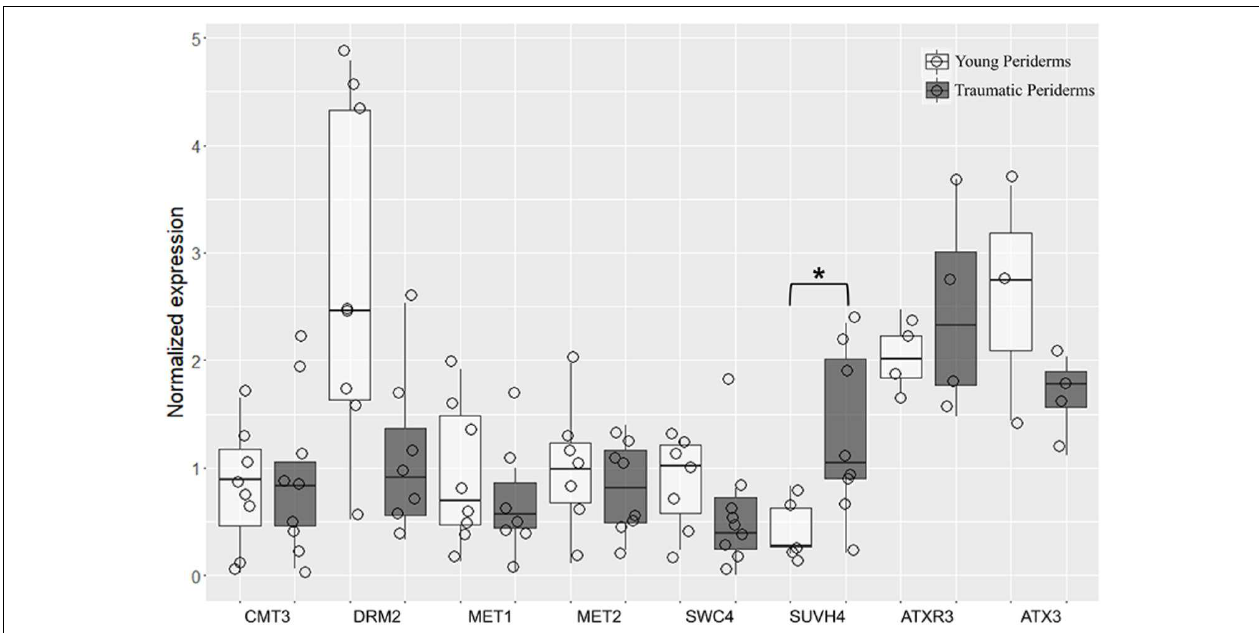
FIGURE 9 | Quantitative real-time PCR (qRT-PCR) evaluation of QsCMT3 , QsDRM2 , QsMET1 , QsMET2 , QsSWC4 , QsSUVH4 , QsATXR3 , and QsATX3 mRNA transcripts at different stages of periderm development: young (one and three-year-old sprigs) and traumatic periderms. Results are expressed as means ± standard deviation of at least six individuals and three technical replicates. Transcript levels were normalized to actin and GAPDH . Asterisks indicate the significance of the difference between young and traumatic periderms. Boxplots represent minimum relative expression, first quartile (bottom of box), median, third quartile (top of box), and maximum. The relative expressive of every individual is represented by jittered